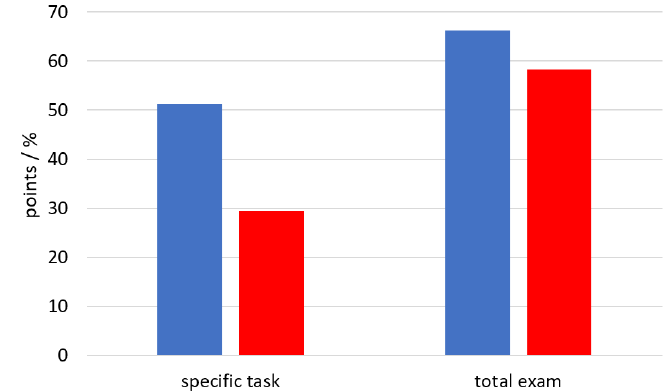
Fig. 11. Results in an exam (N=39). Blue: VR-group, red: control group. Average points achieved in a specific stream filament related task and total points in